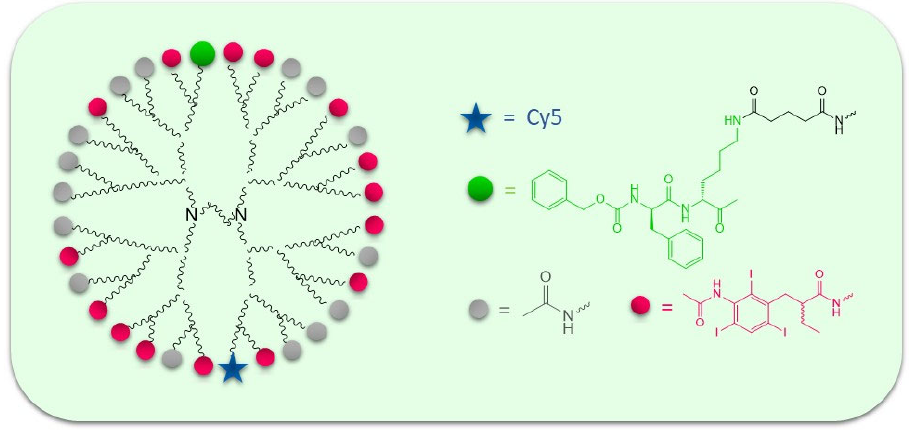
Figure 11. Structure of the iodinated nanoscale ABP. The ABP comprises the recognition sequence carrying an acyloxymethyl ketone. The detection unit is based on a polyamidoamine (PAMAM) core dendrimer on which 16 iodine tags are attached, each containing three iodine atoms.